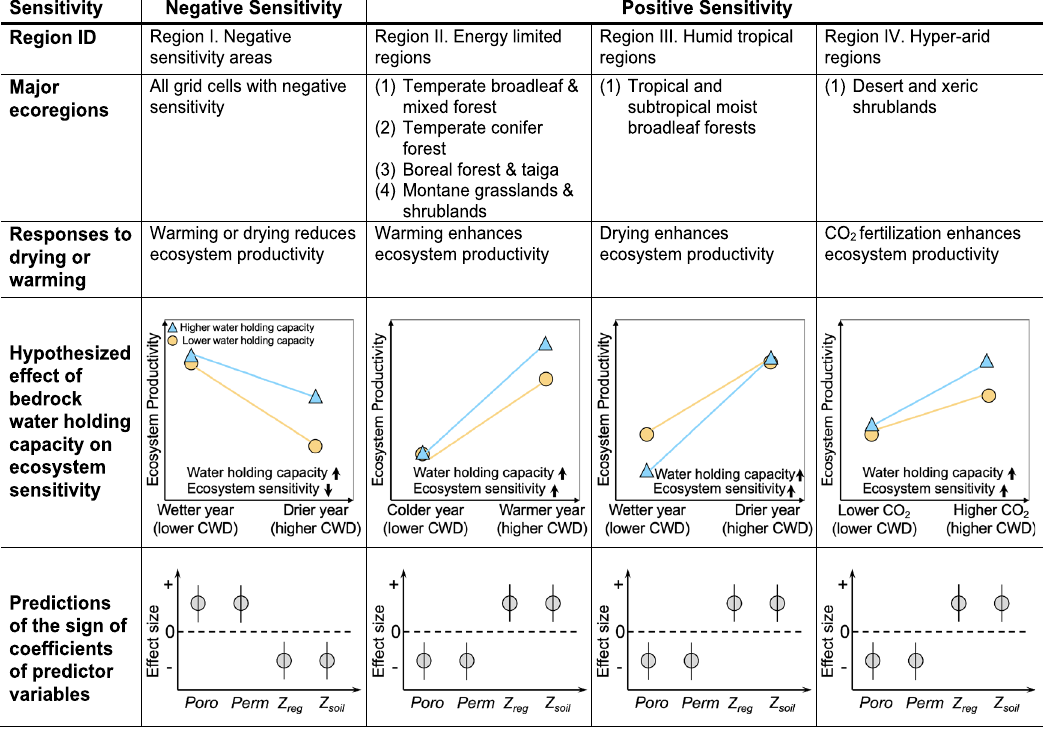
Fig. 1 Classi fi cation of four regions globally and hypothesized region-speci fi c effect of bedrock water holding capacity on ecosystem sensitivity. The global terrestrial surface is divided into four regions, according to the sign of calculated ecosystem sensitivity and primary constraints of ecosystem productivity for different ecoregions (Table S1; Figs. S1 and S2). We hypothesize that the effect of bedrock water holding capacity on ecosystem sensitivity (steeper slope represents higher sensitivity) varies by region and list predictions of model results (signs of coef fi cients in Eq. 5) if the hypotheses are supported. “ Poro ” - porosity, “ Perm ” - permeability, “ Z Reg ” - thickness of regolith, “ Z soil ” - soil thickness. In the last row: the mean effect size is represented by a circle and vertical lines describe 95% credible intervals of the effect